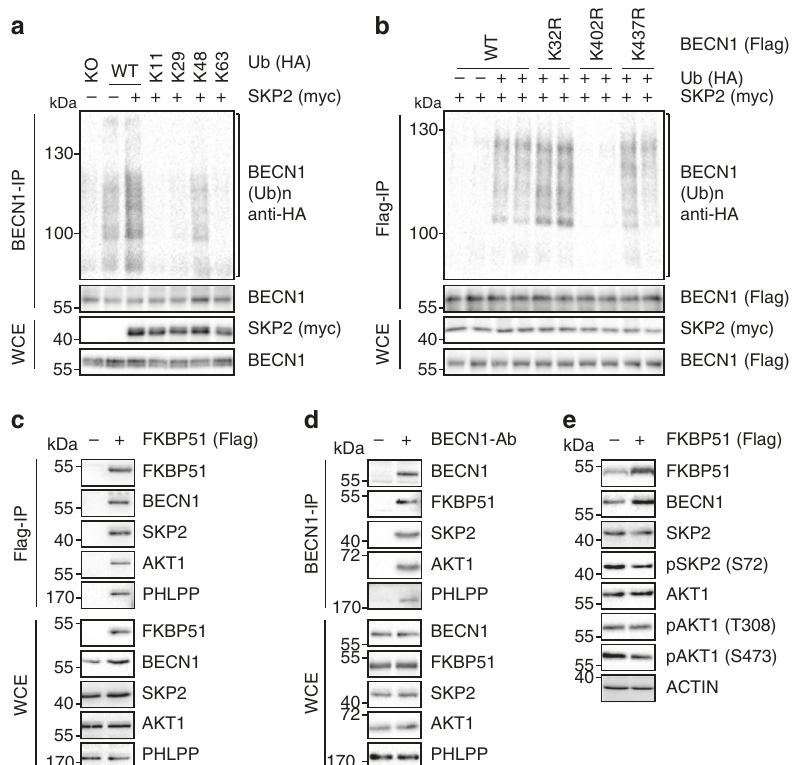
Fig. 3 SKP2 executes K48-linked poly-ubiquitination at K402 of BECN1. a , b SKP2 attaches K48-linked poly-ubiquitin at K402 of BECN1. HEK293 cells were transfected with plasmids expressing either WT HA-tagged ubiquitin or mutant forms featuring only one lysine together with an SKP2 expressing plasmid or vector control ( a ). In b , cells were transfected with plasmids expressing BECN1, either WT or the indicated mutants, myc-SKP2 and HA- ubiquitin. Ubiquitination of BECN1 was determined after immunoprecipitation. c – e Association of FKBP51 and BECN1 with regulatory kinases. HEK293 cells were transfected with FKBP51-Flag expressing plasmid ( c , e ) and protein extracts were used for western blot analysis after 72 h of cultivation ( e ) or immunoprecipitation of FKBP51 ( c ). In d , endogenous BECN1 was precipitated from cell extracts. Blot collections are provided as a Source Data fi